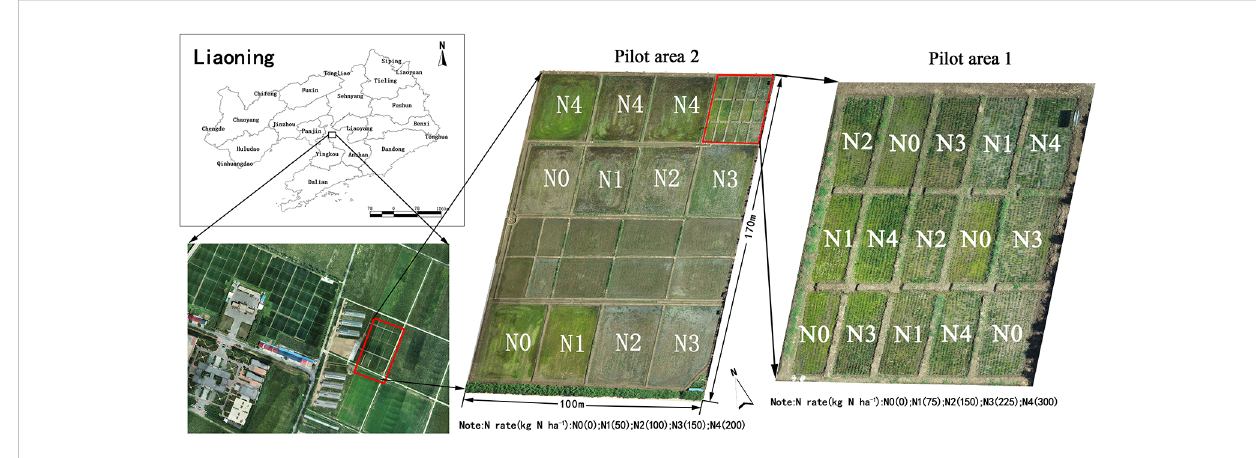
FIGURE 1 Plot distribution of experimental fi eld